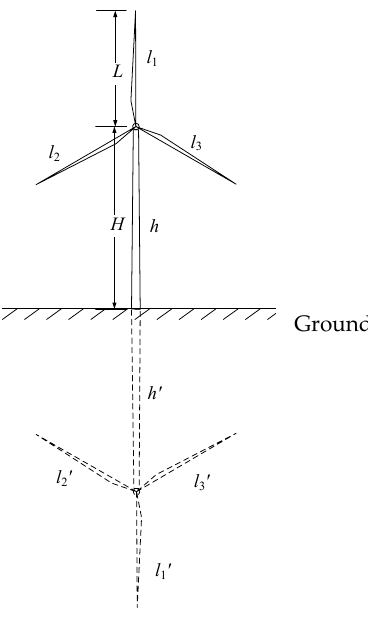
Figure 3. Schematic of a WT and its mirror image.